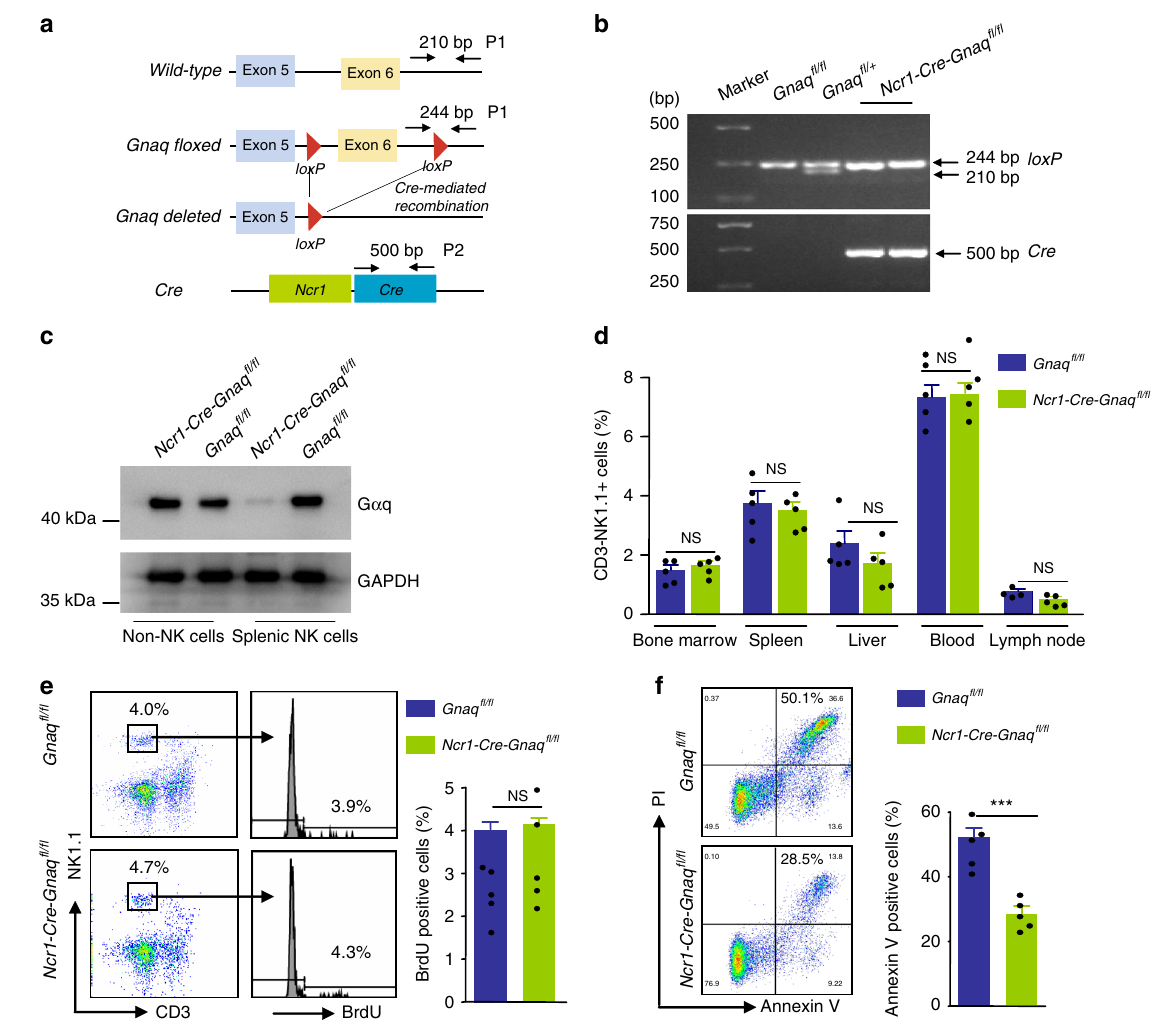
Fig. 3 G α q de fi ciency leads to enhanced NK cell survival. a In Gnaq fl / fl mice, exon 6 of the Gnaq gene is fl anked with loxP sites. Crossing Gnaq fl / fl mice with Ncr1-Cre mice leads to Cre -mediated recombination, resulting in exon 6 deletion. The diagram is not to scale. b Genotyping of mouse tail DNA for the presence of Cre recombinase transgene and a fl oxed transgene. Genomic PCR was performed on DNA derived from different mice. The presence of the Cre recombinase gene is detected by the ampli fi cation of a 500-bp product. The fl oxed products expected (244 bp) are shown. c G α q protein levels were measured by western blot in splentic NK and non-NK cells from Ncr1-Cre-Gnaq fl / fl and Gnaq fl /f mice. d The frequencies of NK cells in the bone marrow, spleen, peripheral blood, liver, and lymph node in Ncr1-Cre-Gnaq fl / fl and Gnaq fl /f mice ( n = 5 per genotype). Bar graphs show the percentage of NK cells (CD3 − NK1.1 + ). Data are representative of two independent experiments. e In vivo proliferation of splenic NK cells. Mice were injected intraperitoneally with BrdU (2 mg), and after 12 h, the incorporation of BrdU in splenic NK cells was analyzed. Numbers adjacent to outlined areas in the dot plot indicate the percentage of CD3 − NK1.1 + cells. Histograms show the percentage of BrdU-positive cells ( n = 5 per genotype). Data are representative of two independent experiments. f Puri fi ed splenic NK cells were cultured in media without IL-2 for 6 h, and viability was monitored by Annexin V staining. Histograms show the percentage of Annexin V-positive cells ( n = 5 per genotype). Data are representative of two independent experiments. All data are expressed as the mean ± s.e.m.; NS, not signi fi cant. * P < 0.05, ** P < 0.01, *** P < 0.001, unpaired two-tailed Student ’ s t -test. Source data are provided as a Source Data fi